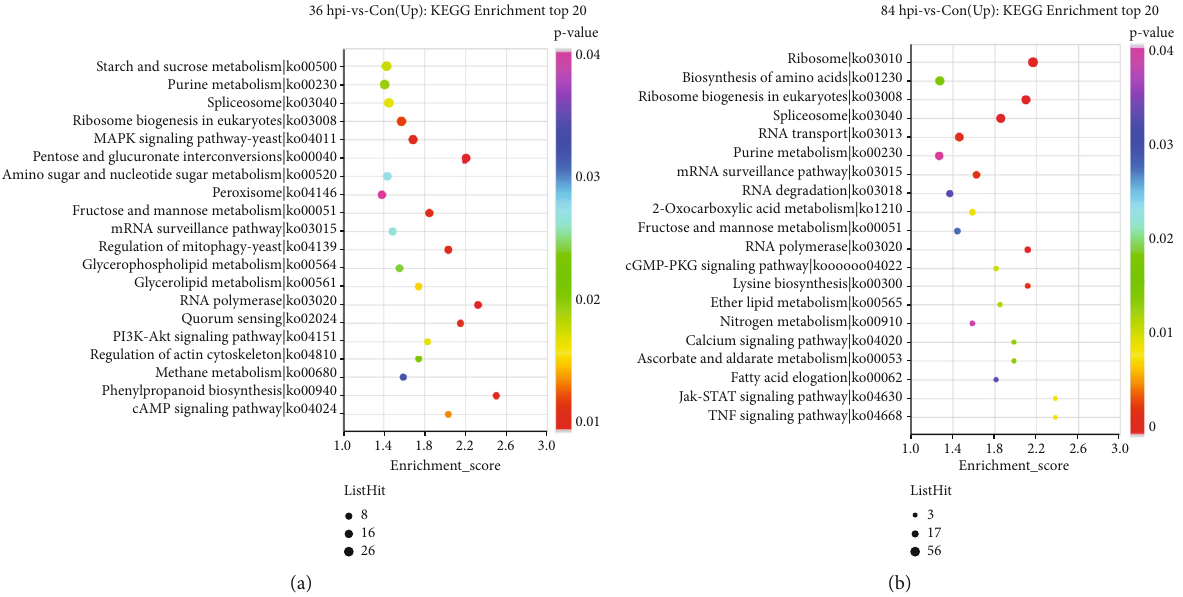
Figure 5: KEGG enrichment analysis of the upregulated DEGs of S . lycopersici . (a) The top 20 enriched KEGG terms of the upregulated genes in 36 hpi-vs-Con. (b) The top 20 enriched KEGG terms of the upregulated genes in 84 hpi-vs-Con. The y -axis has descriptions of the corresponding KEGG